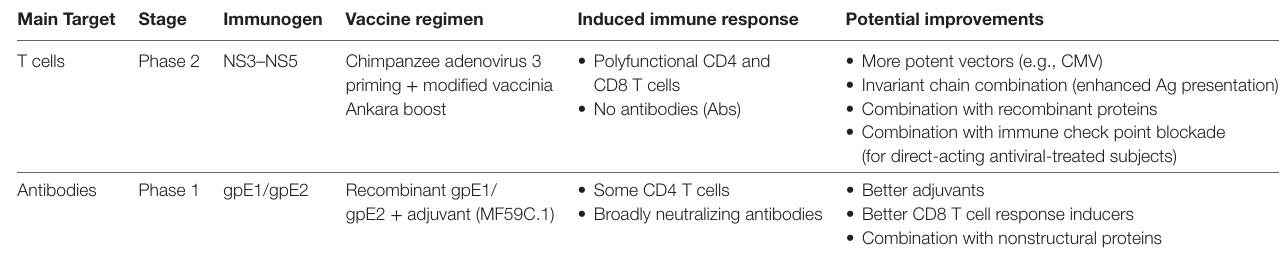
TAbLe 1 | Current hepatitis C virus vaccine development